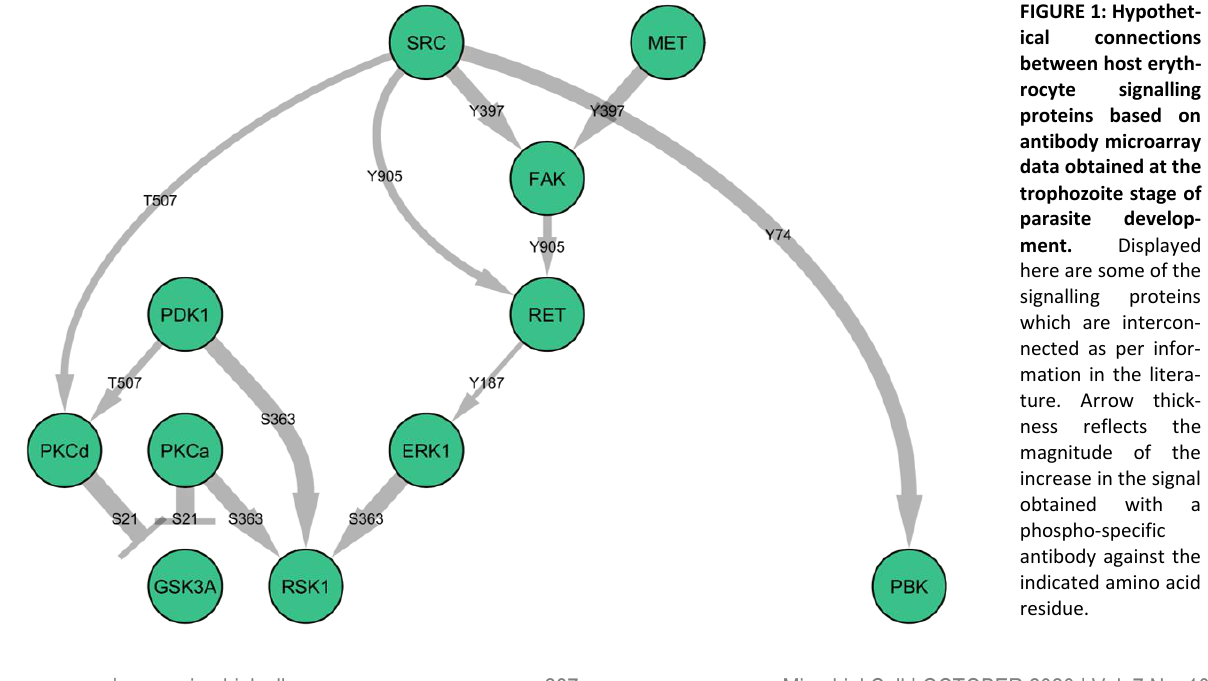
FIGURE 1: Hypothet- ical